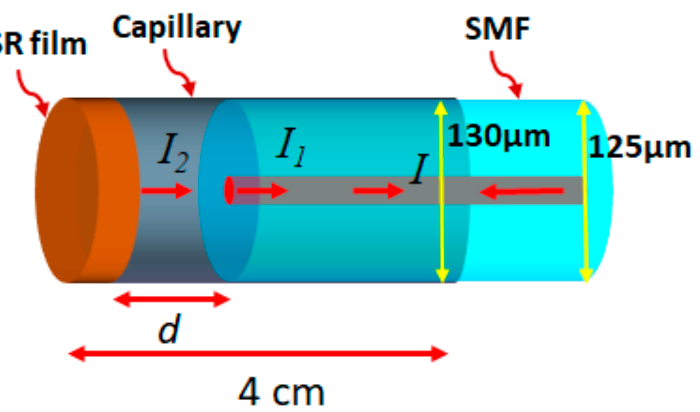
Figure 1. Schematic illustration Fabry–Perot interferometer (FPI) where d refers to the distance between silicone rubber (SR) film and tip of single mode fiber (SMF), I 1 and I 2 refer to the intensity of light reflected from the tip of SMF and the SR film, respectively, and I refers to the total intensity ( I 1 + I 2 ).